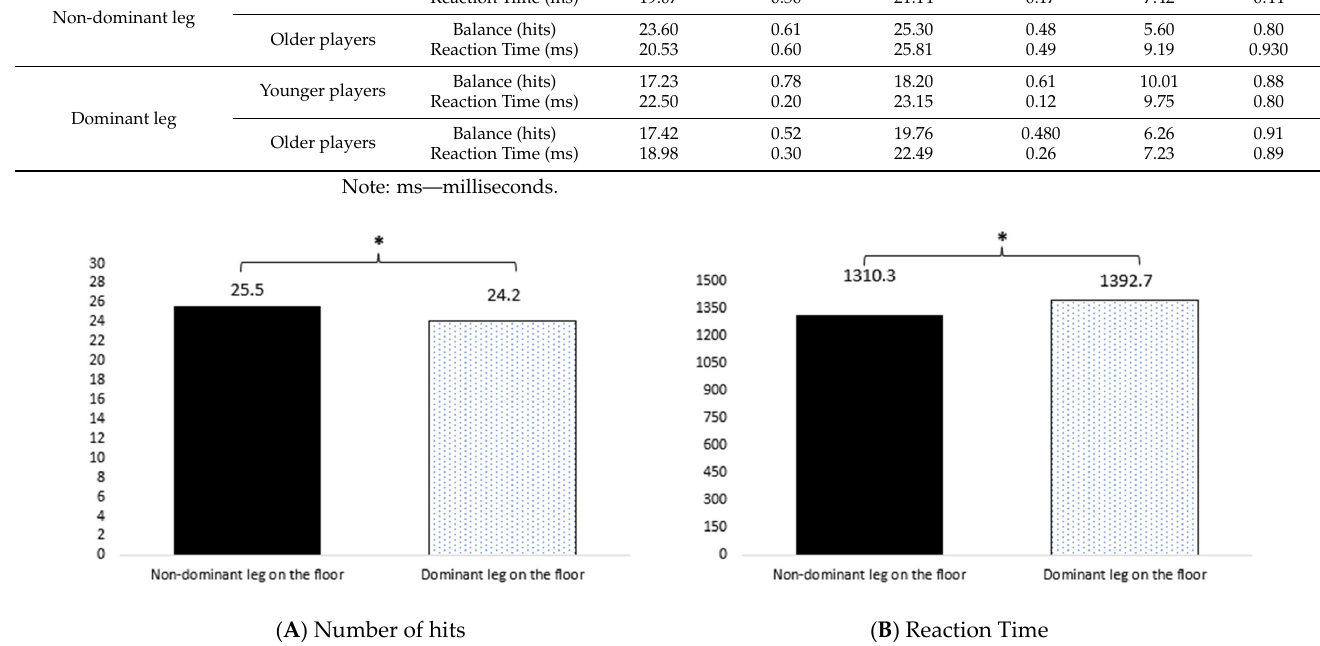
Figure 2. Comparisons between dominant and non-dominant leg. Note: * p < 0.05. Table 5 shows the correlation between age, experience, stature, body mass, and BMI with the number of hits and RT (best trials) when controlling by age group. Results showed that age is associated with the number of hits and RT, especially in older players. Table 5. Correlations between age, experience, stature, body mass, and BMI with the number of hits and RT controlled by age